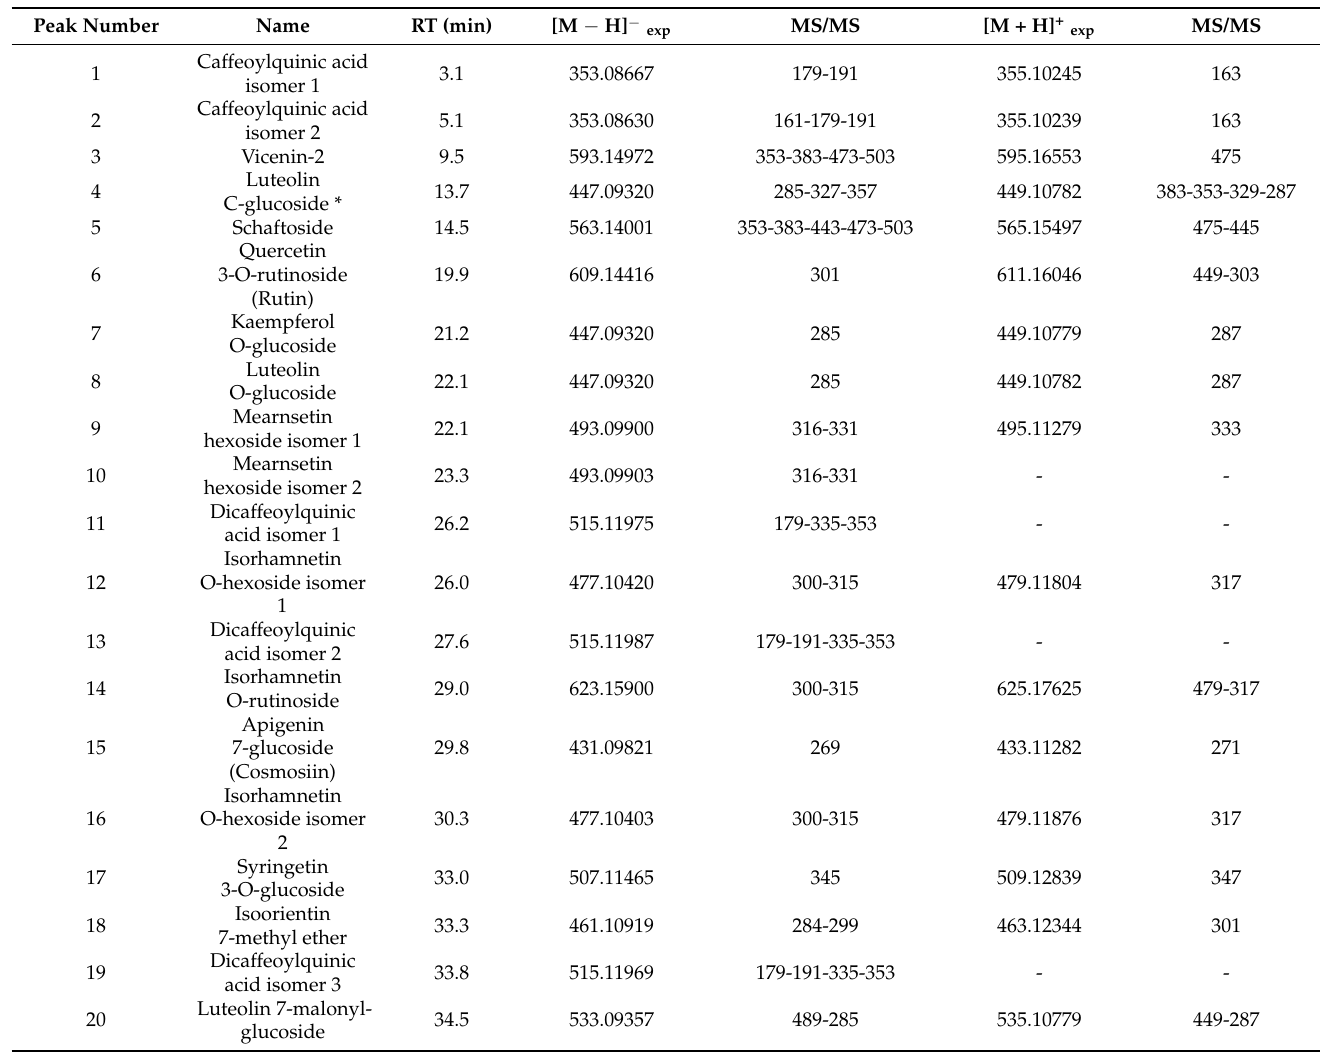
Table 1. LC-ESI-(+/ − )-MS identification of the constituents of the two extracts of Achillea moschata . The peak numbers refer to those reported in Figure 2. * Compounds found only in the methanolic